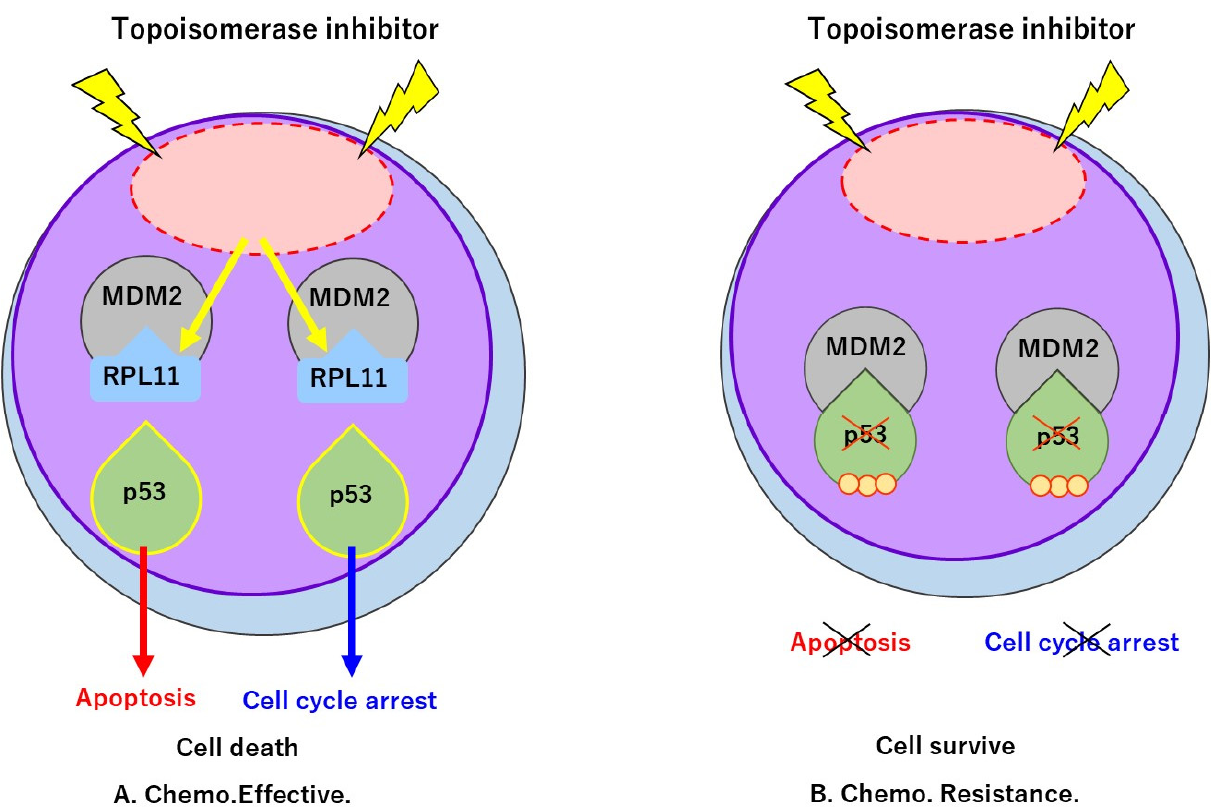
Figure 6. Nucleolus stress response may be one of the determinants of topoisomerase inhibitor sensitivity in cancer. ( A ) When RPL11 is normally expressed, topoisomerase inhibitors induce RPL11 to bind to MDM2 and block ubiquitination-dependent degradation of p53. Consequently, cancer cells inhibit cell growth and induce apoptosis. ( B ) When the expression of RPL11 is low, RPL11 is unable to induce sufficient inhibition of MDM2, resulting in the destabilization of p53 and resistance to topoisomerase inhibitors in cancer cells.